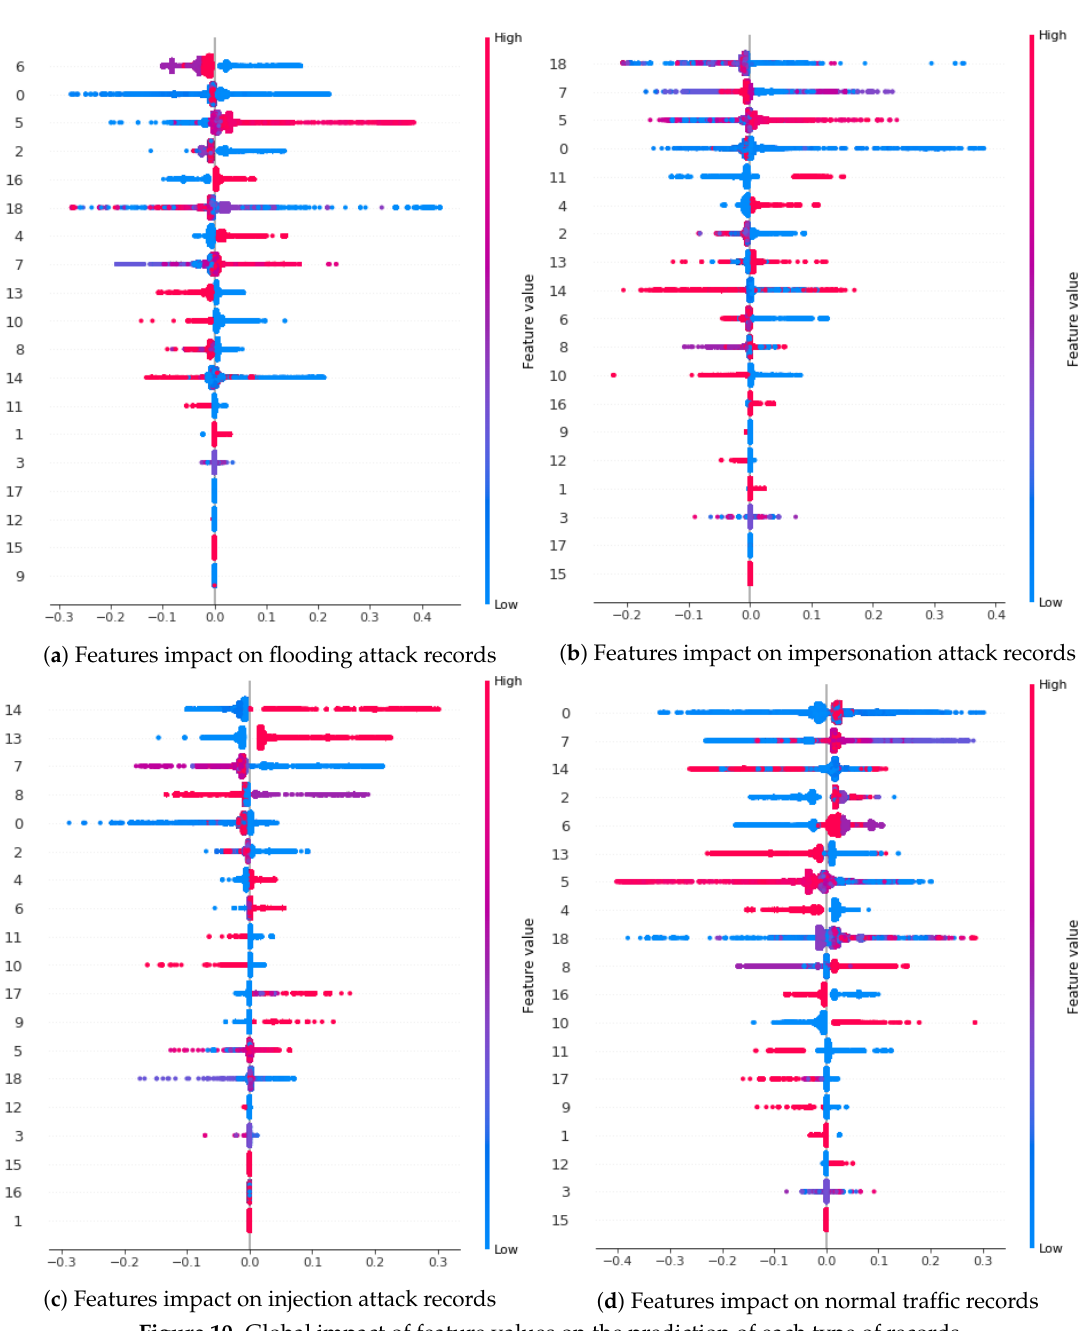
Figure 10. Global impact of feature values on the prediction of each type of records. Table 9. Top 5 influential features and their values for each traffic